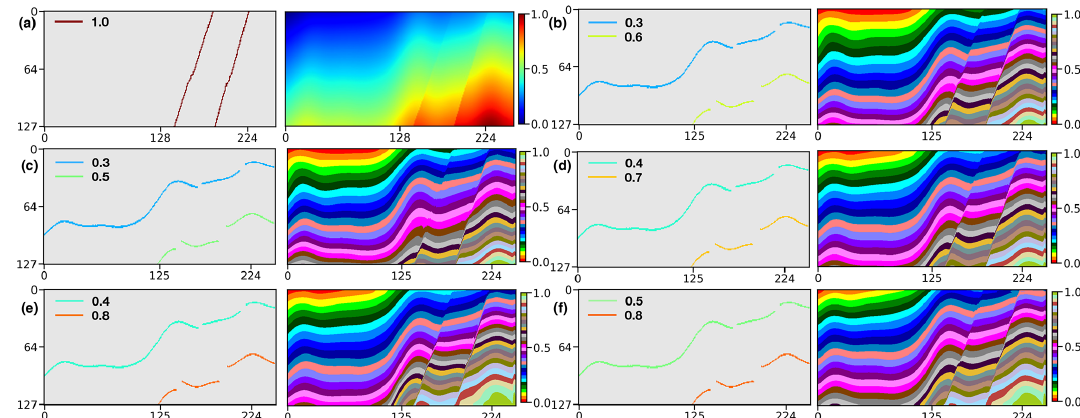
Figure 8. We use a synthetic model (a) to study how the varying horizon values impact the CNN’s modeling results. As shown in panels (b) to (f) , the experiments are used to verify that our network can produce almost identical structural models from the same faults and the horizons with different annotations. These indicate that our approach is not sensitive to the changes in the labeled value on each horizon in the inputs, which facilitates its application in field